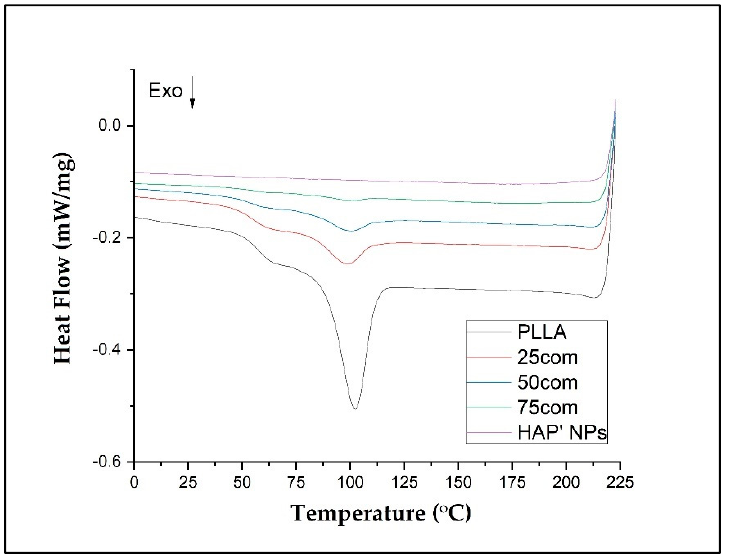
Figure 9. DSC curves of cooling segments for composites 25com, 50com, and 75com, as well as HAP NPs and PLLA samples.